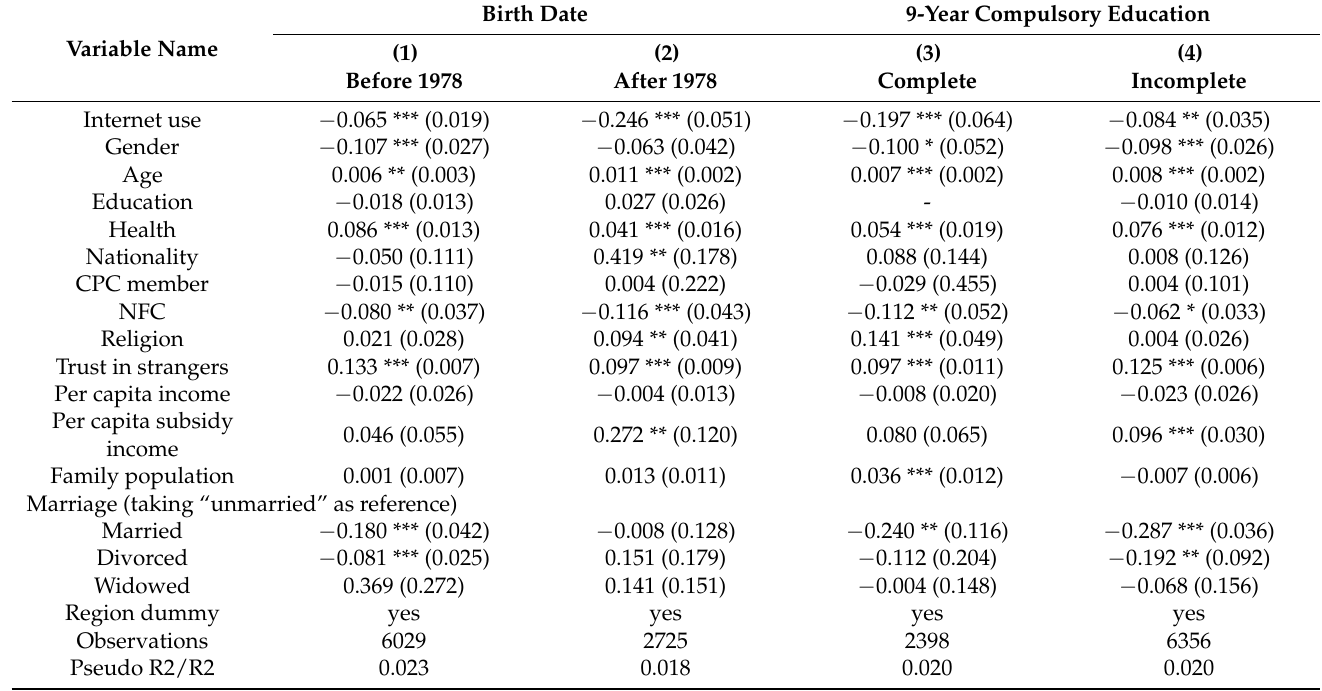
Table 3. Results of heterogeneity